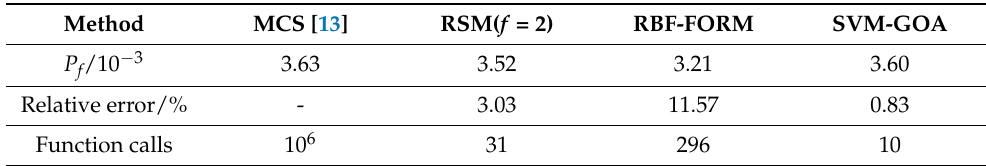
Table 4. Comparison of calculation results of Case 1.